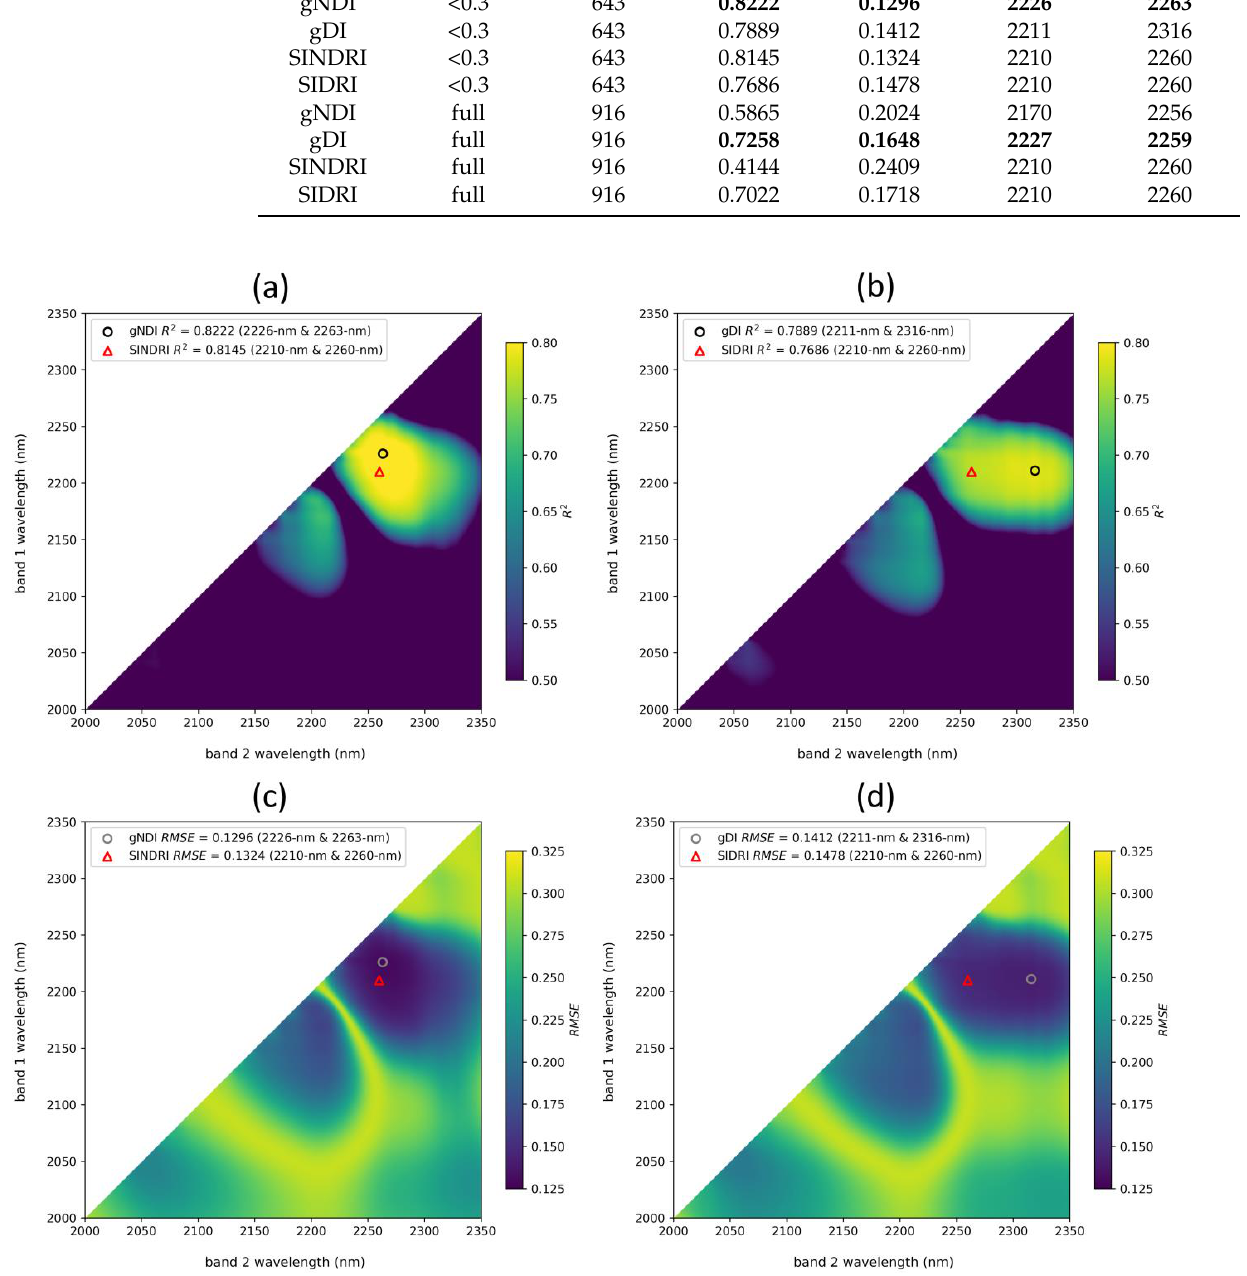
Table 2. Two-band wavelength shift analysis performance for 1 nm interval (30 nm bandwidth) BARC dataset. For nearly all statistical performance metrics ( R 2 , RMSE ), the 1 nm interval dataset results demonstrate higher explained variance and lower error than the 10 nm dataset in f R estimation but identify very similar top-performing bands (see Table 1). Band-1 and Band-2 denote the wavelengths with the highest f R estimation performance for both R 2 and RMSE. Top-performing bands and indices for each NDVI case have been bolded.